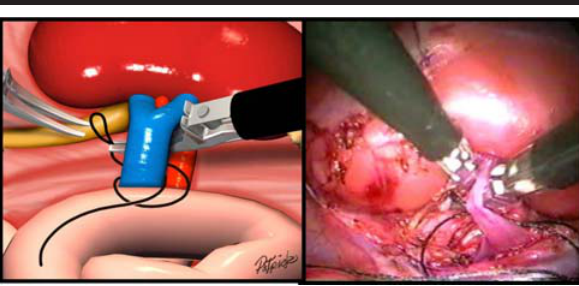
FIGURE 3 - The suture is passed again behind the renal